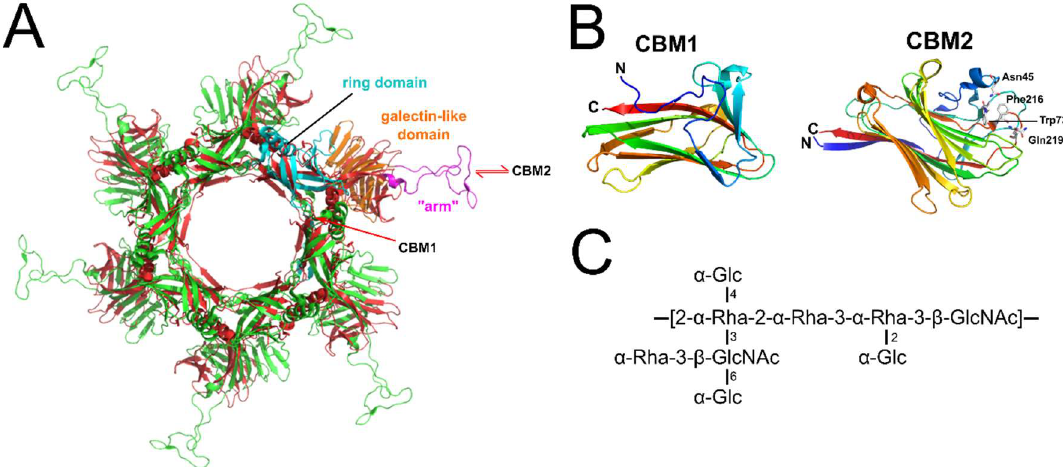
Figure 3. “Evolved” Dits feature with receptor-binding carbohydrate-binding modules (CBMs). ( A ) Cartoon superposition of the hexameric Dit hub structures from L. lactis phage p2 (gp15; green) [16] and B. subtilis phage SPP1 (gp19.1; red) [12] shown passing through the central symmetry axis of the tail. The domains of a single p2 Dit protein are colored separately: cyan, N-terminal ring domain (residues 1 to 136); orange, galectin-like domain (residues 137–146 & 189–298); and magenta, “arm” protrusion (residues 147–188) used for RBP attachment. Red arrows indicate estimated locations of the two CBMs of the phage J-1 “evolved” Dit: CBM1 is proposed to insert after the N-terminal ring domain, and CBM2 within a loop of the galectin-like domain [53]. ( B ) Cartoon representation of the putative CBM1 fold (PDB ID: 2XOM) [55] and the known CBM2 fold (PDB ID: 5LY8) [53]; both are rainbow colored from N-terminus (blue) to C-terminus (red). Shown as white sticks are four residues (Asn45, Trp73, Phe216, and Gln219) that are proposed to form the CWPS binding site of CBM2 [53].